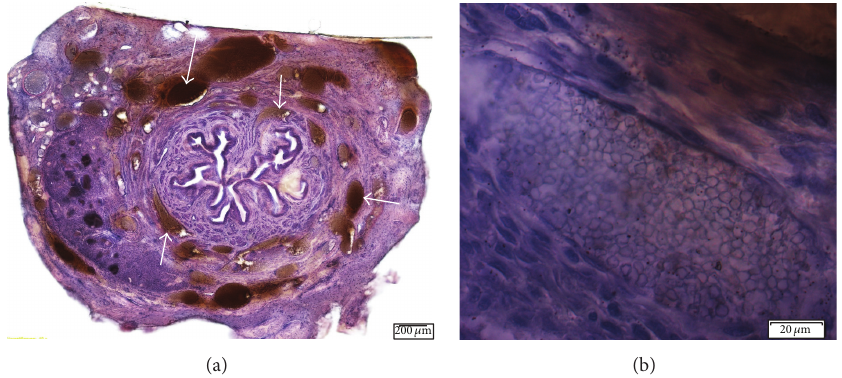
Figure 2: Cross-sections of urethra 5 months after injection of SCPC10 particles. (a) Cross-sectional view of entire urethra with nodular particle packets in the submucosa and adventitia (10x magnification). Arrows indicate particle masses. (b) Particle packet in a well circumscribed nodule showing some surface irregularities and size variability of the individual particles (20x